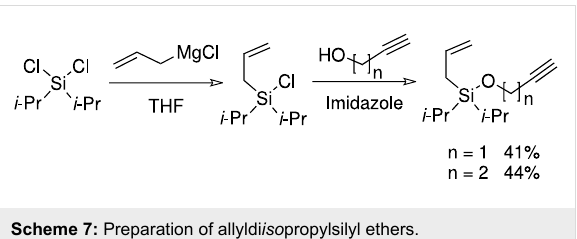
Figure 3: Possible structure of THF-oxidation/insertion product.